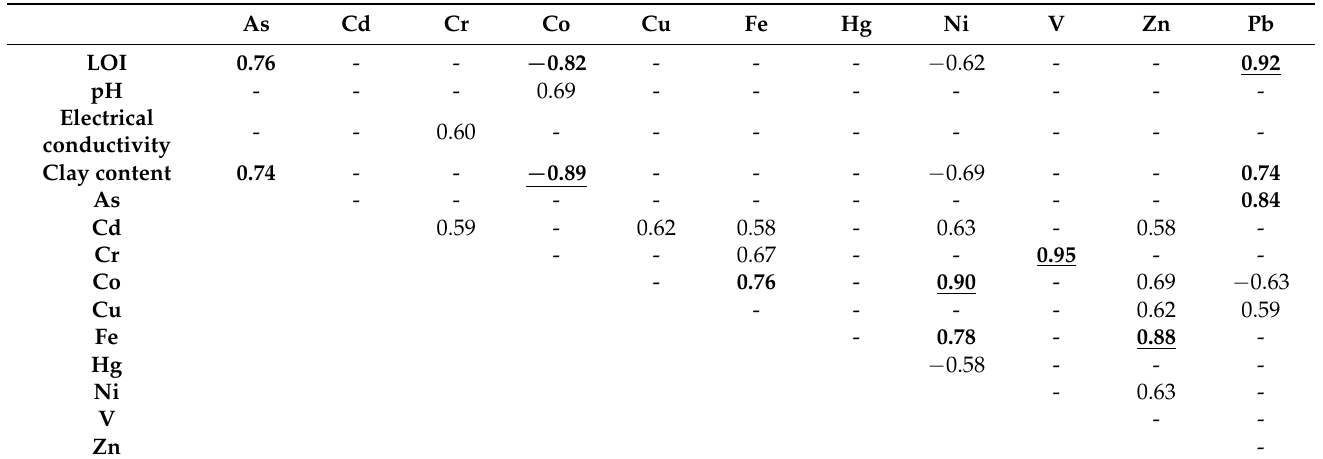
Table 6. Spearman correlations (rho values) in the soil samples from the Einsiedel Reservoir catchment ( n = 12).